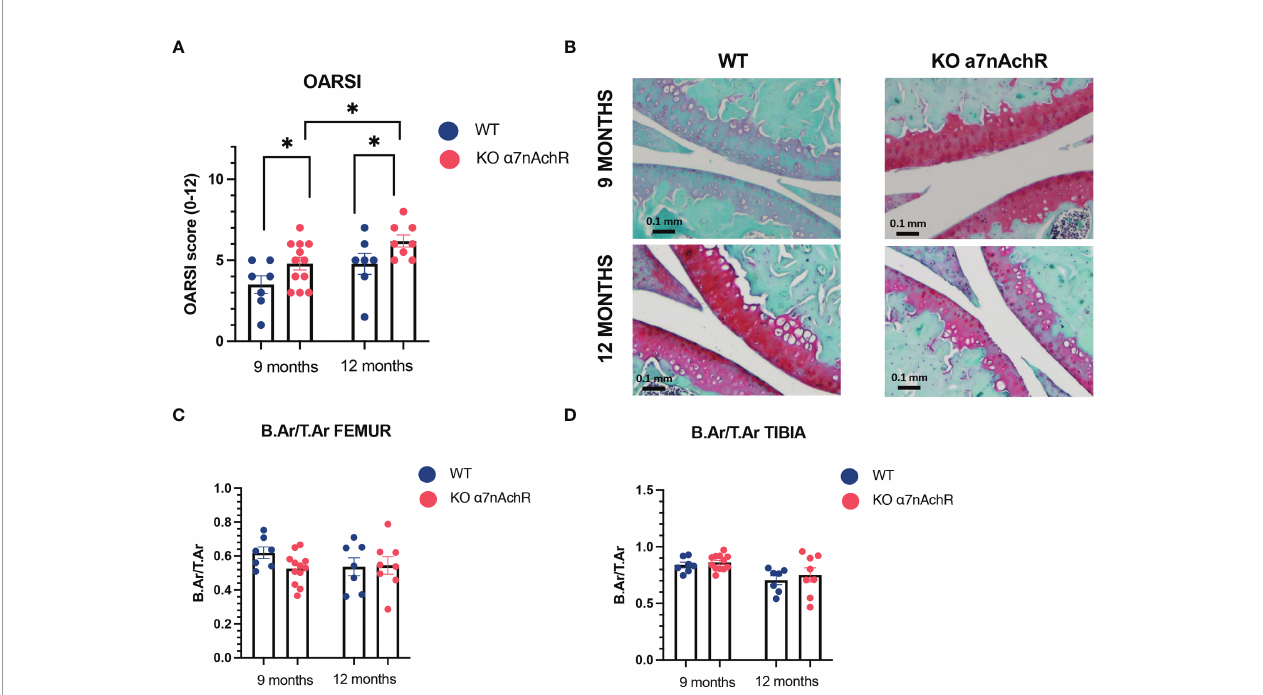
FIGURE 3 | Cartilage and subchondral bone histological analysis in 9- and 12-month WT and Chrna7 -/- male mice. (A) OARSI score of the sum of femoral condyle and tibial plateau (0 – 12, 12 being the worst) between 9-month WT ( n = 7) and Chrna7 -/- ( n = 12) and 12-month WT ( n = 7) and Chrna7 -/- ( n = 8) male mice. (B) Representative Safranin O/fast green-stained sections of the right knee of 9- and 12-month WT and Chrna7 -/- mice. (C) B.Ar/T.Ar femur and (D) tibia subchondral bone of the 9-month WT ( n = 7) and Chrna7 -/- ( n = 12) and 12-month WT ( n = 7) and Chrna7 -/- ( n = 8) male mice, * p < 0.05 using non parametric t